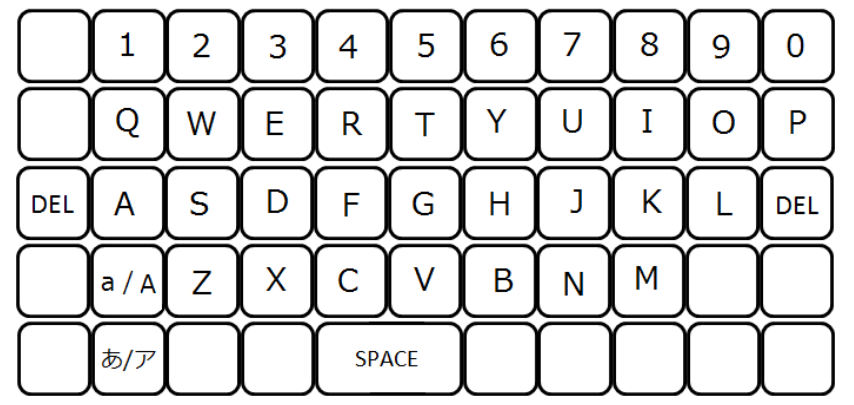
Figure 4. Region of interest location of the registration process.